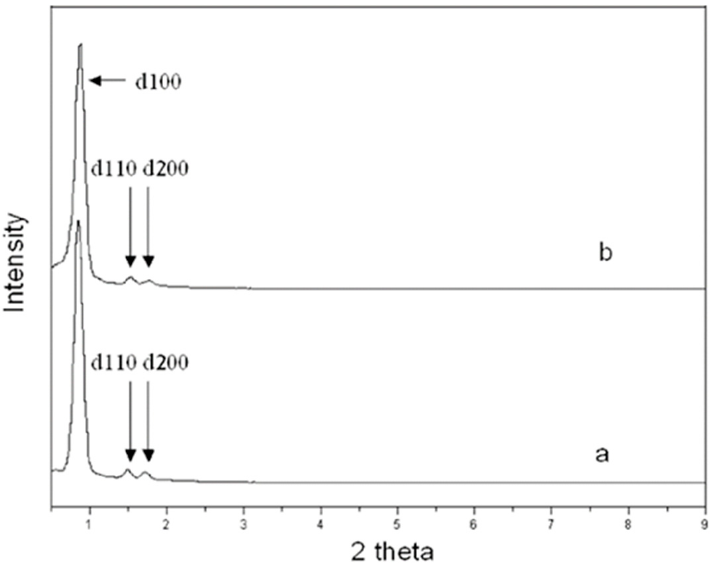
Figure 5. Small angle X-ray scattering patterns for calcined ( a ) SBA-15 and ( b ) plugged SBA-15 [18].